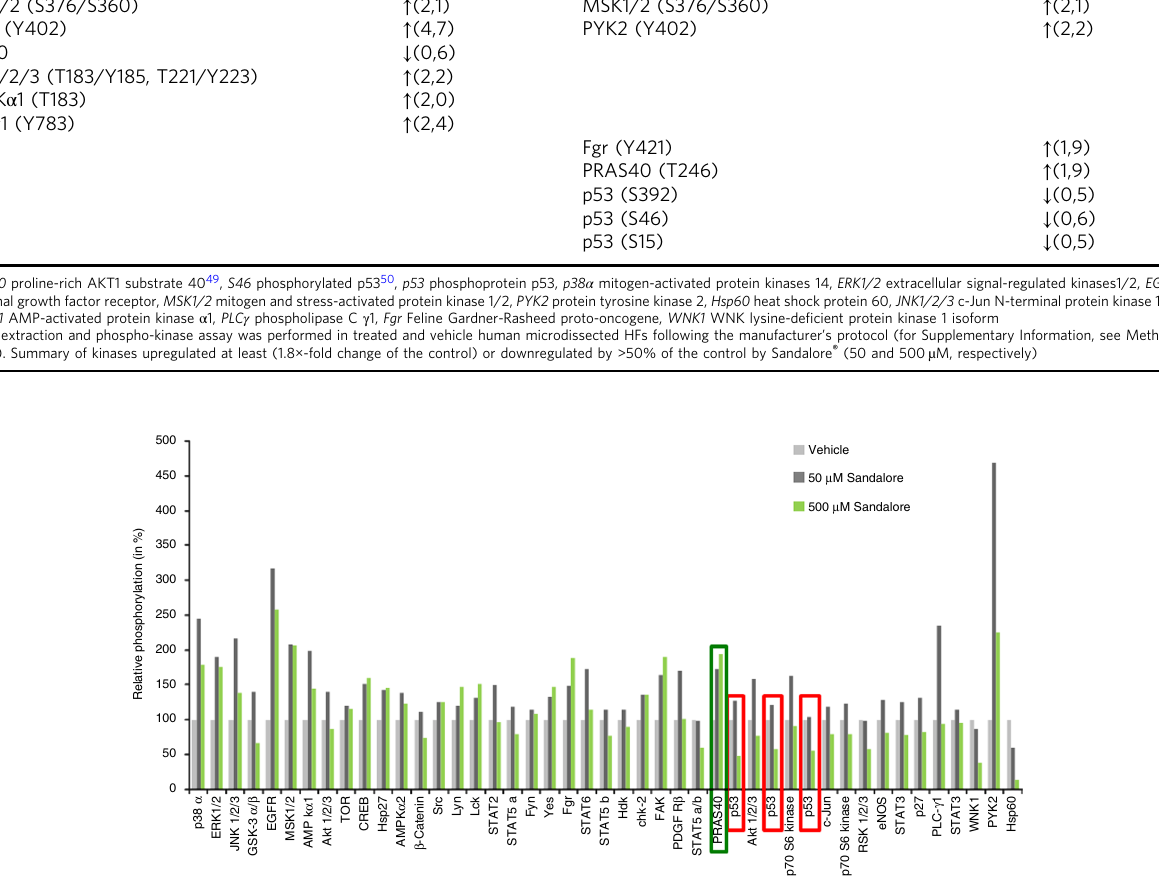
(Intas, Germany). Protein expression levels were normalized to corresponding actin levels. The uncropped blots are presented in the Supplementary Fig. 8. Hair cycle score (HCS) and staging . HFs were microscopically evaluated for the hair cycle staging analysis using Masson – Fontana histochemistry and Ki-67/ TUNEL immunostainings 25,26 . The HCS was also measured 25,31 , which consists of assigning an arbitrary unit for each stage of the hair cycle (Anagen VI = 100; Early catagen = 200; Mid-catagen = 300; and Late catagen = 400). After having classi fi ed each HF according to its hair cycle stage, following the previously de fi ned objective classi fi cation criteria for organ-cultured human HFs 26 , for each experimental condition, the mean HCS was calculated. The closer the mean is to 100, the higher is the number of anagen VI HFs in a given group. The HCS provides a global read- out parameter that looks at all HFs in a given experimental group and synthesizes them into a single number, which re fl ects how close the majority of HFs is to either anagen VI or catagen and also permits statistical analysis that it is not possible with